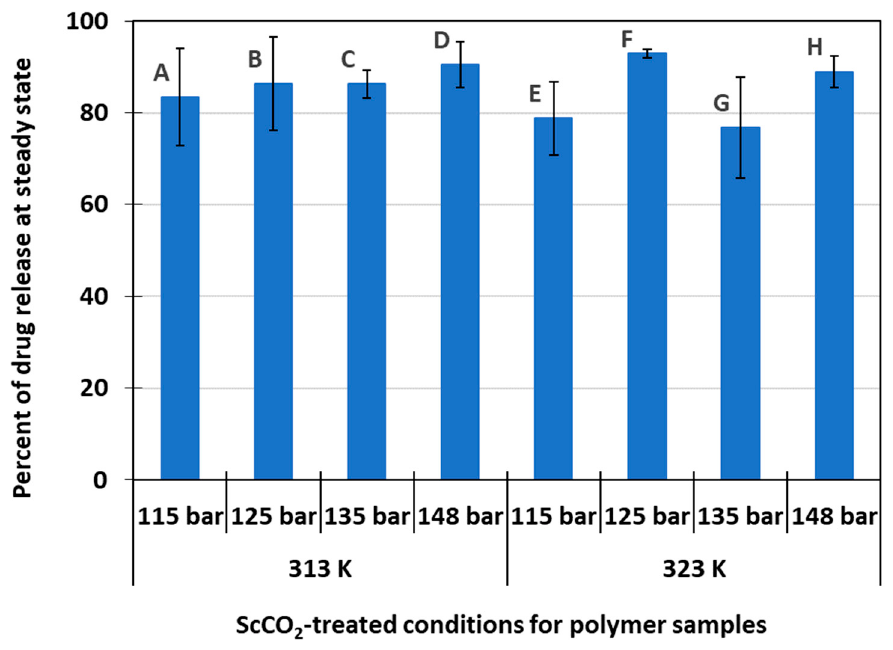
Figure 4. Steady state drug release level for samples treated under di ff erent scCO 2 conditions.